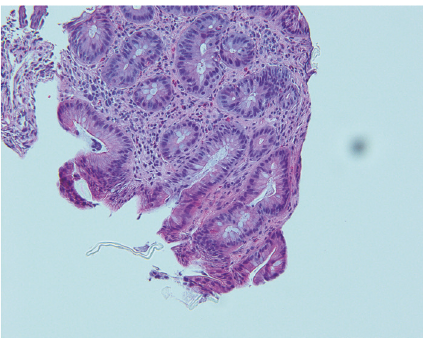
Figure 2: Ascending mucosal biopsy demonstrating ulceration and active inflammation.